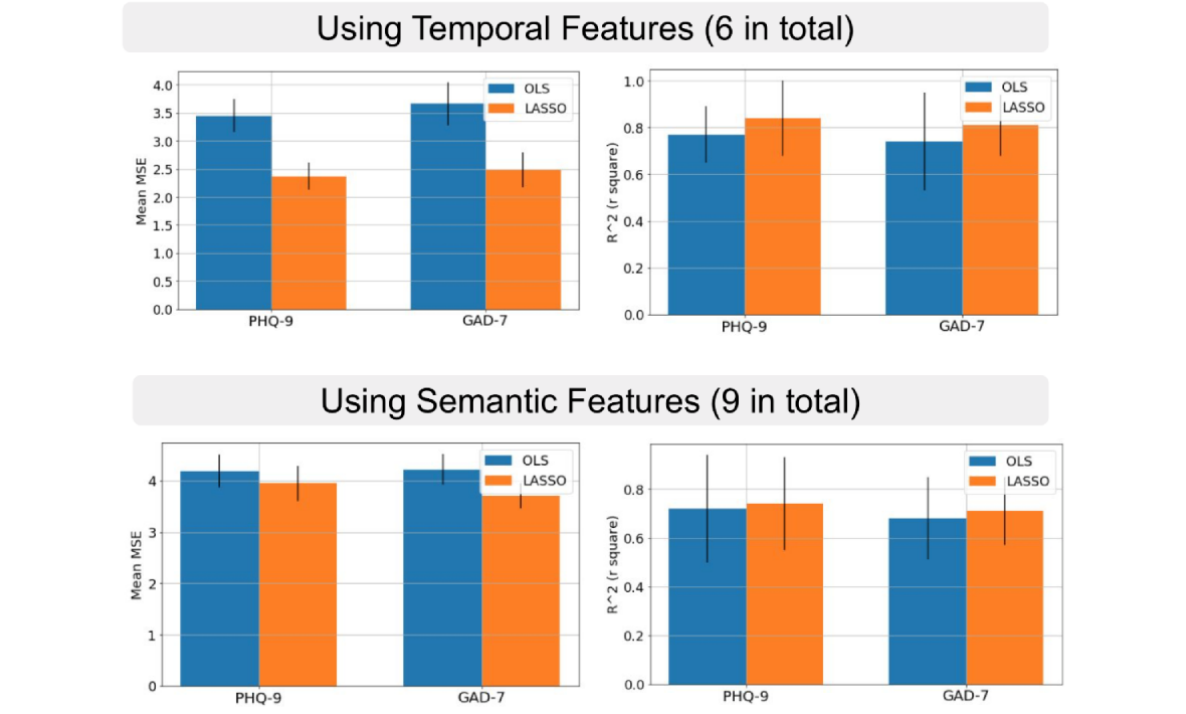
Figure 8. The performances of the two regression models averaged across 49 leave-one-out splits. GAD-7: General Anxiety Disorder-7; LASSO: lasso regression; MSE: mean squared error; OLS: ordinary least square regression; PHQ-9: Patient Health